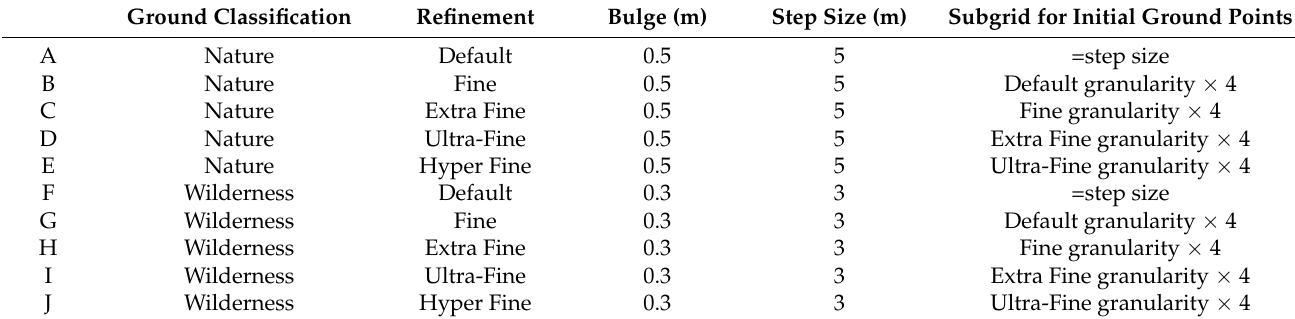
Table 2. LASTools ground classification parameter modifications used in ground classification iteration